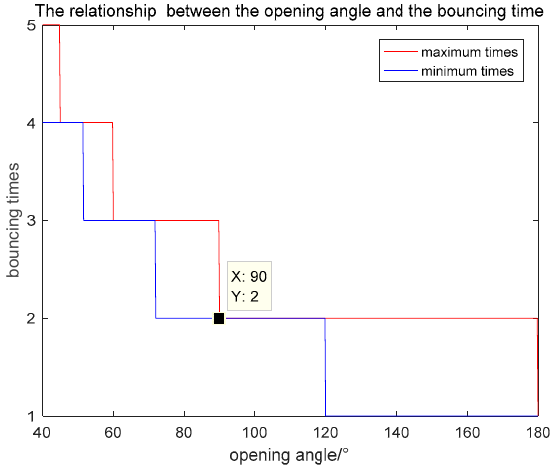
Figure 6. Relationship between the opening angle and the bouncing time.